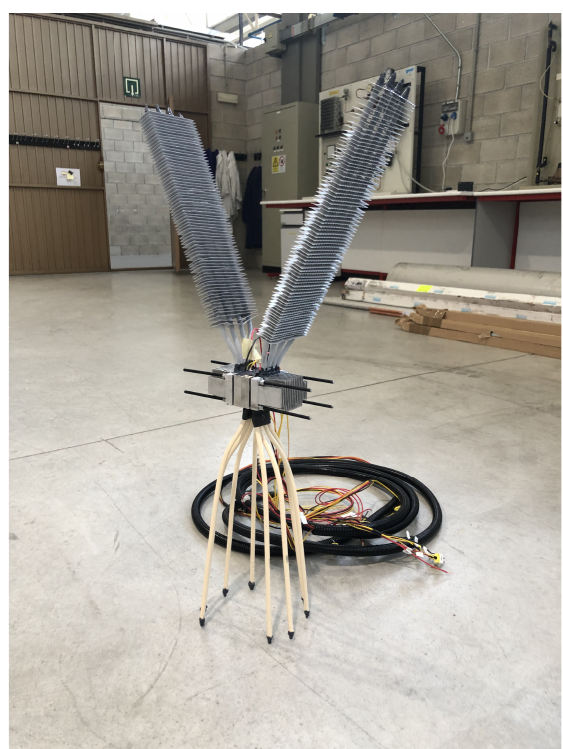
Figure 2. Designed thermoelectric generator composed of two thermoelectric modules and heat pipes as heat